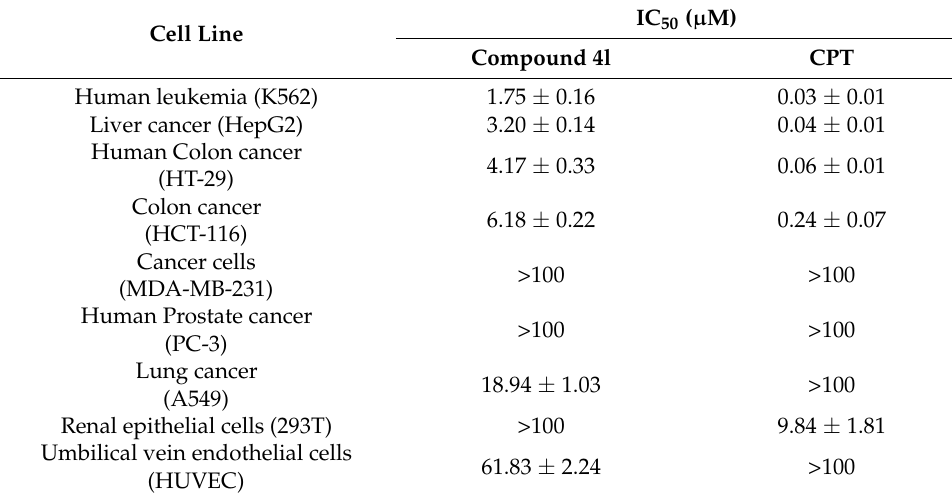
Table 2. In vitro cell proliferation inhibitory activities of compound 4l and CPT .